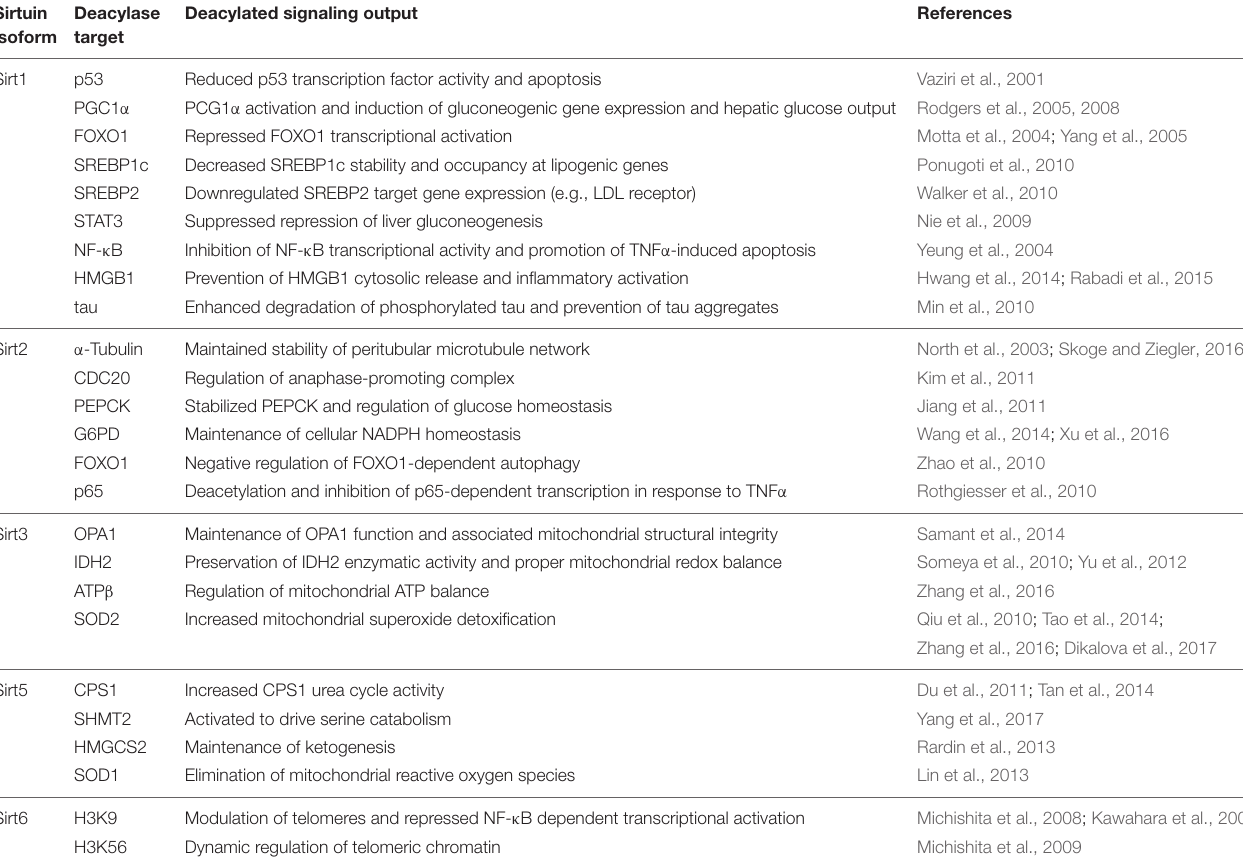
TABLE 2 | Role of Sirt1, Sirt2, Sirt3, Sirt5, and Sirt6 in maintaining cellular metabolic processes, oxidant homeostasis, and reduction of